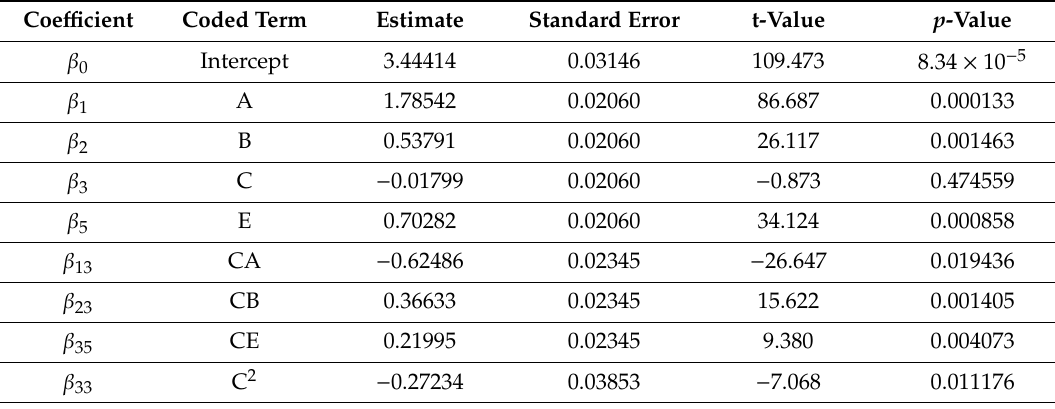
Table 5. Estimates of the regression coe ffi cients of the model described by Equation (2).